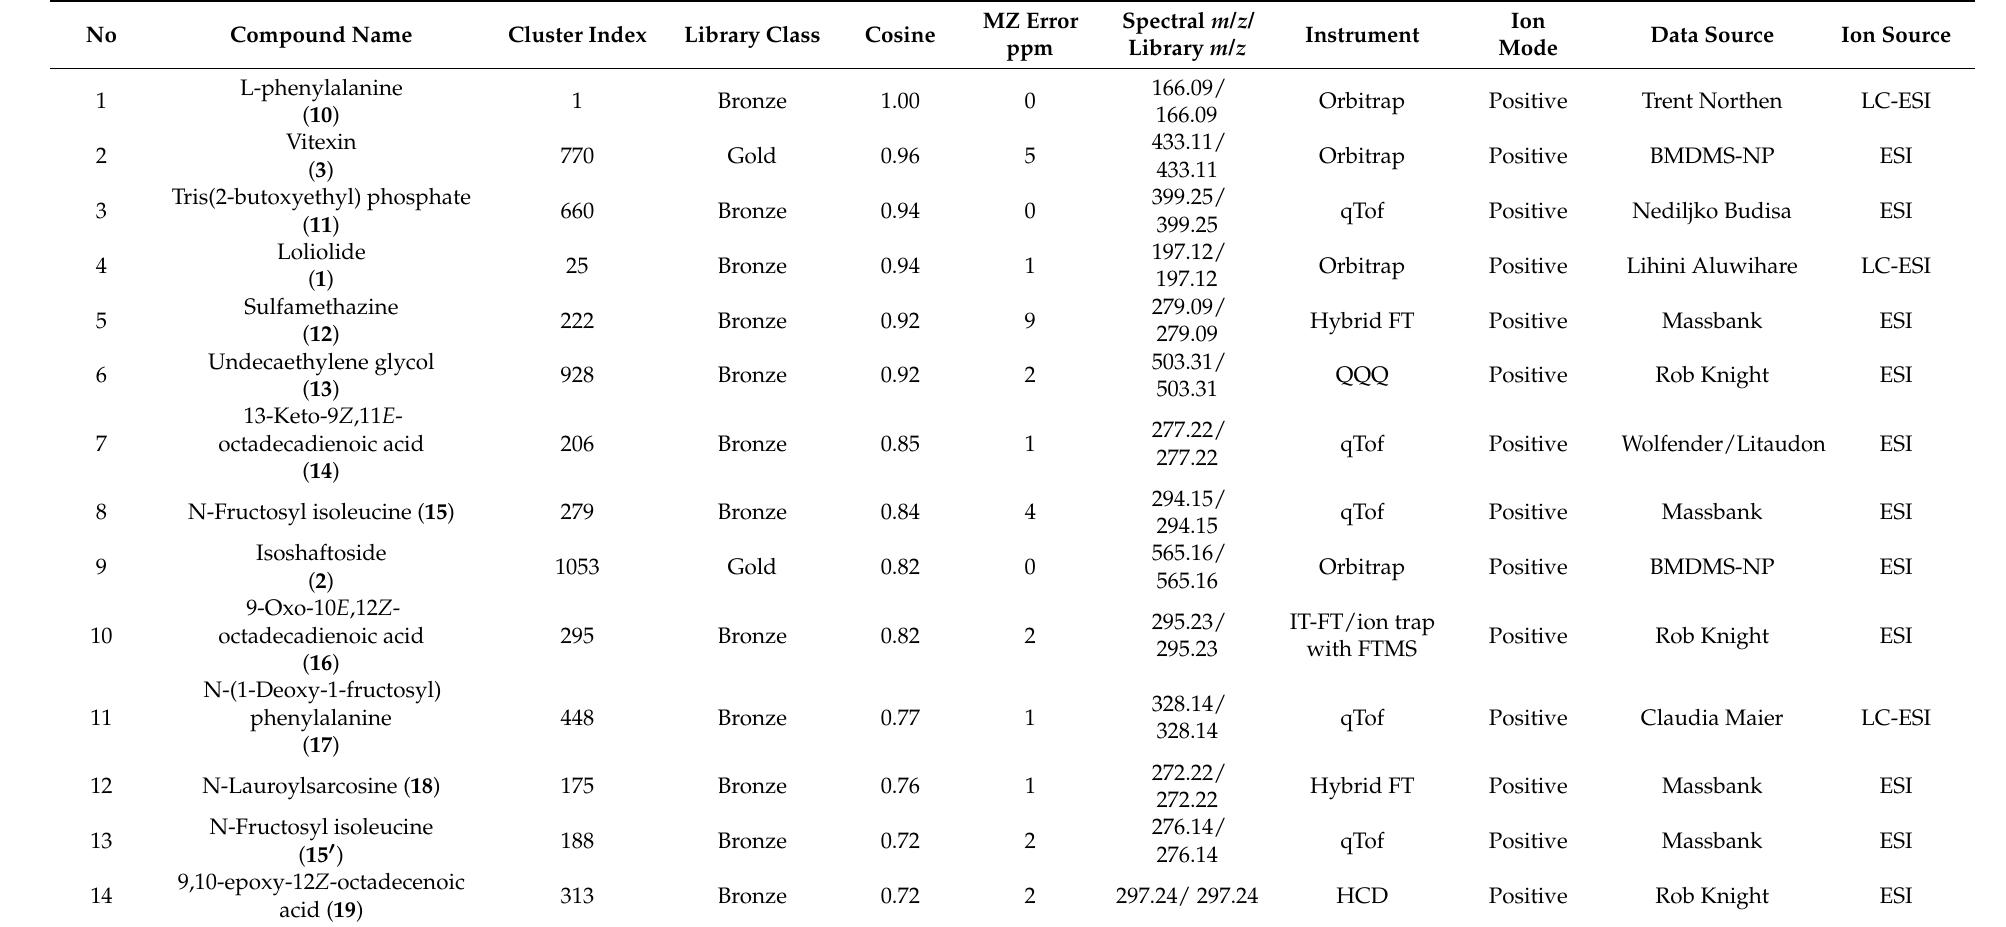
Table 2. Library hits from Feature-Based Molecular Networking in